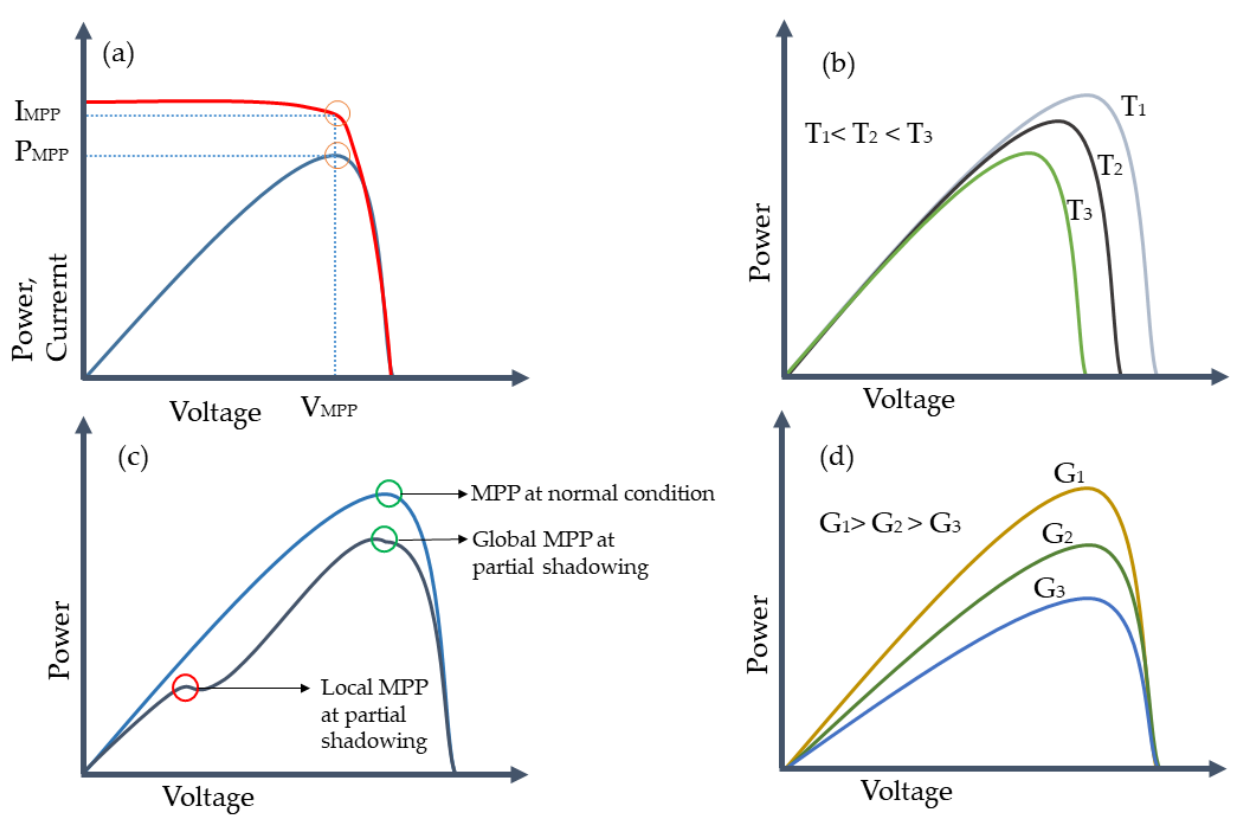
Figure 2. Typical curves for a PV system where: ( a ) is a conventional power-voltage and power-current graph with the MPP highlighted; ( b ) shows how the power-voltage curves change with different temperature at constant irradiation; ( c ) displays the change due to partial shadowing in power-voltage curves; ( d ) exhibits the variation of the power-voltage curves with constant temperature and variable